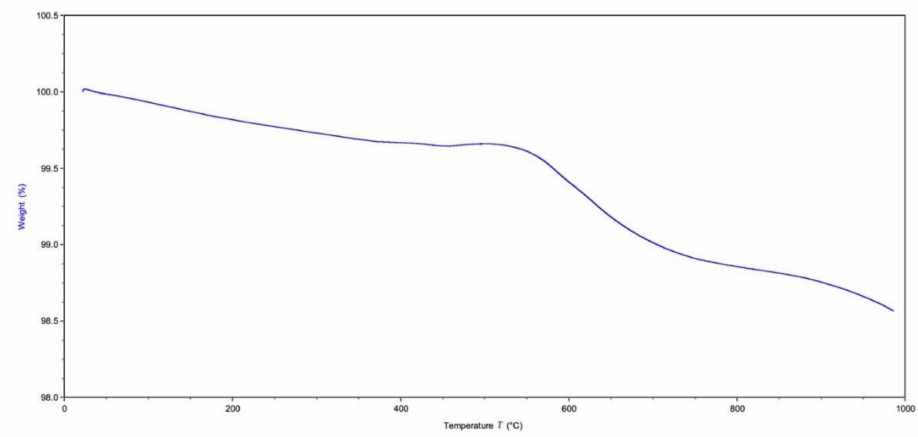
Figure 9. Graphical results of thermogravimetric analysis